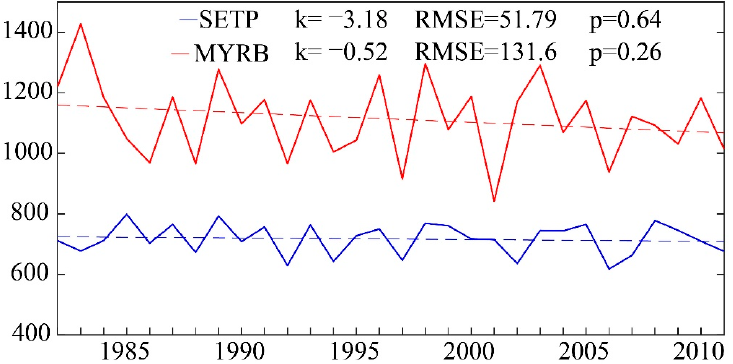
Figure 4. Variations and linear trends of annual mean precipitation (unit: mm) over 1982–2011 in the SETP and the MYRB, based on the station observations of the Chinese Meteorology Administration. K represents the slope of the linear regression lines (unit: mm d − 1 a − 1 ), RMSE represents the root mean square error of the linear regression (unit: mm). The p value is also represented. Table 3. Linear trends of the monthly and wet season (April–September) average of evaporative